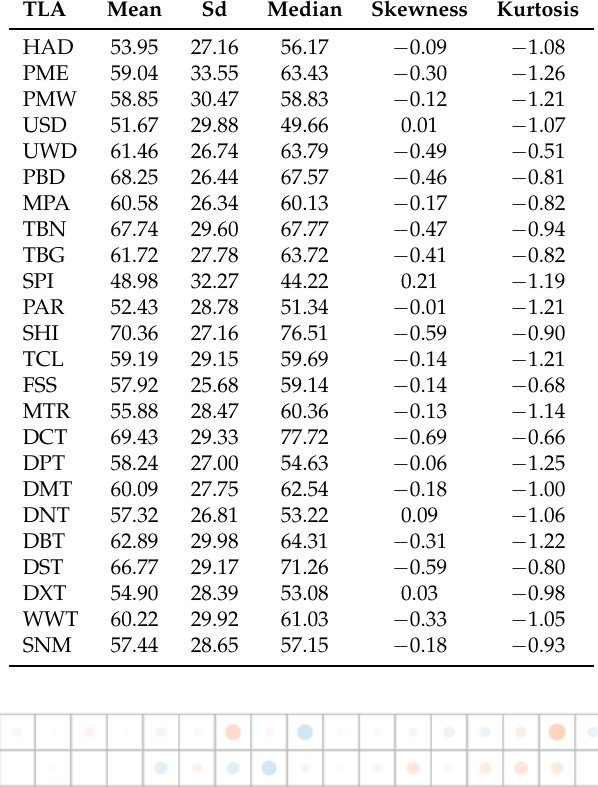
Table 2. Descriptive statistics of the environmental performance indicators.